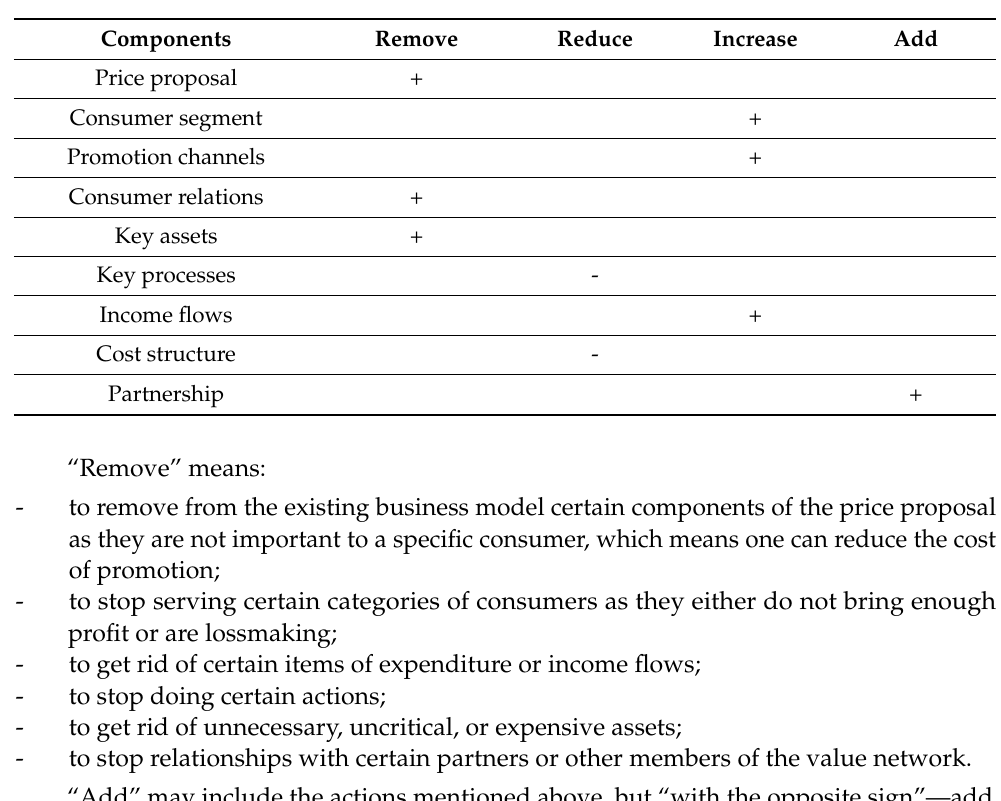
Table 1. Business model correction